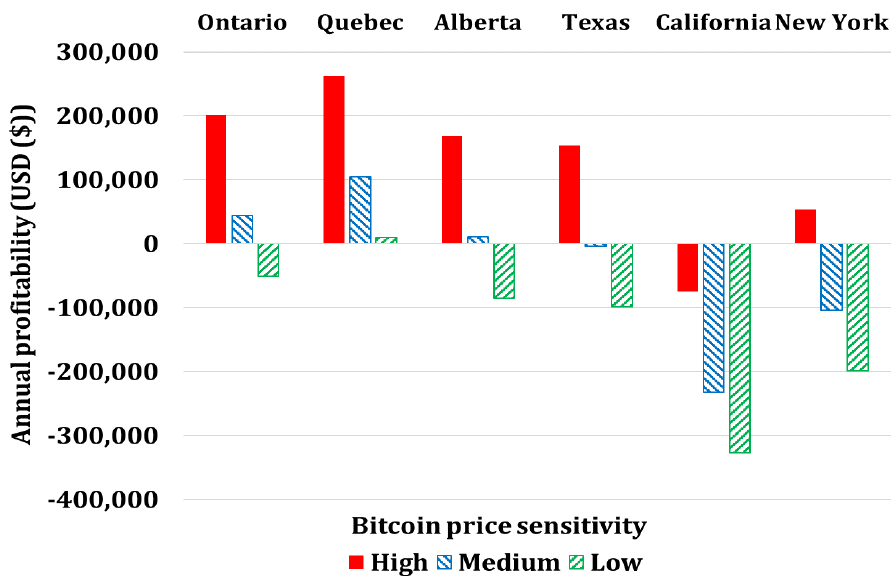
Figure 21. Annual profitability results of operating a DIY mining container in six North American locations measured in USD.